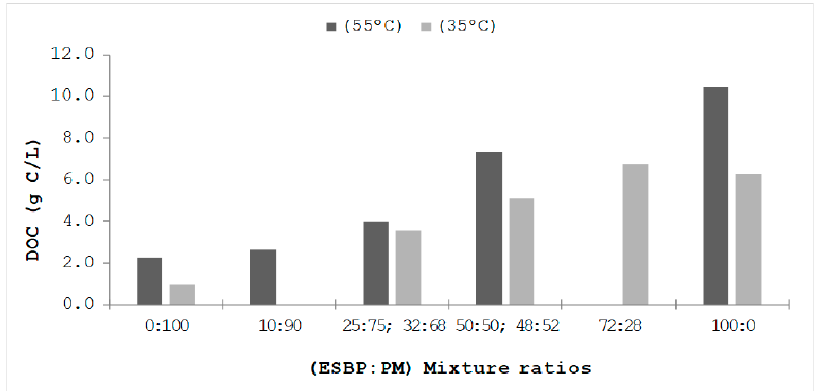
Figure 6. Maximum values of DOC in thermophilic assays (this study) and mesophilic assays [46].